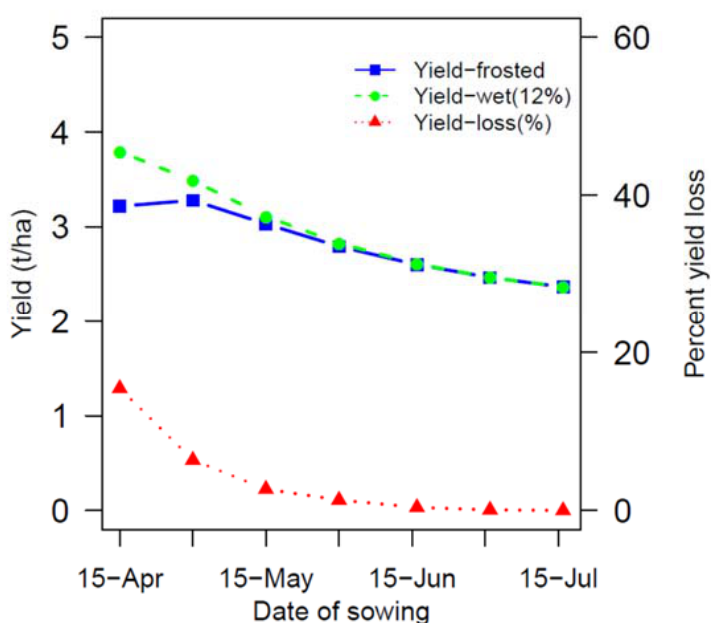
Figure 1. Mean potential yield with of 12% moisture (Yield-wet), frosted yield, and percent yield loss due to frost in chickpea in different sowings on full profile starting soil moisture across 46 locations of the northern grains region.